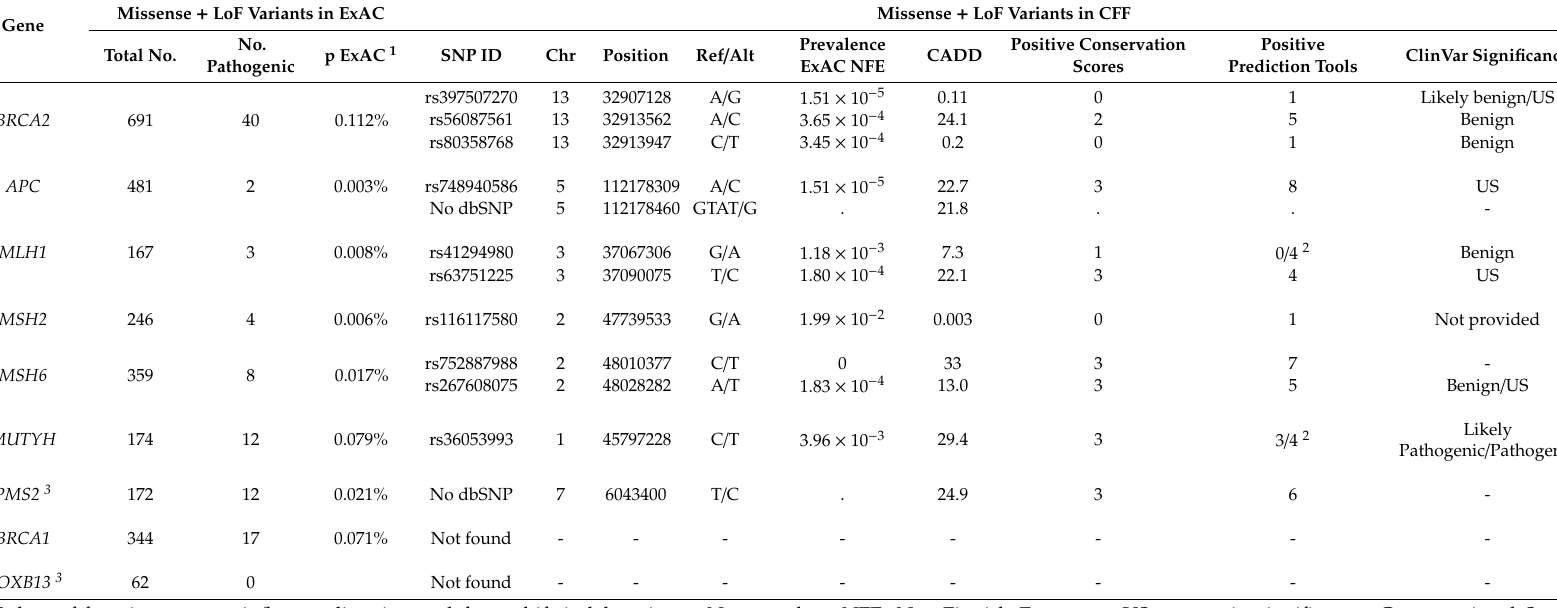
Table 4. List of variants in known high-risk genes in breast, colorectal, and prostate cancers found in cancer-free families (CFFs) with annotations. For the ExAc population, probability of carrying a pathogenic / likely pathogenic variant is